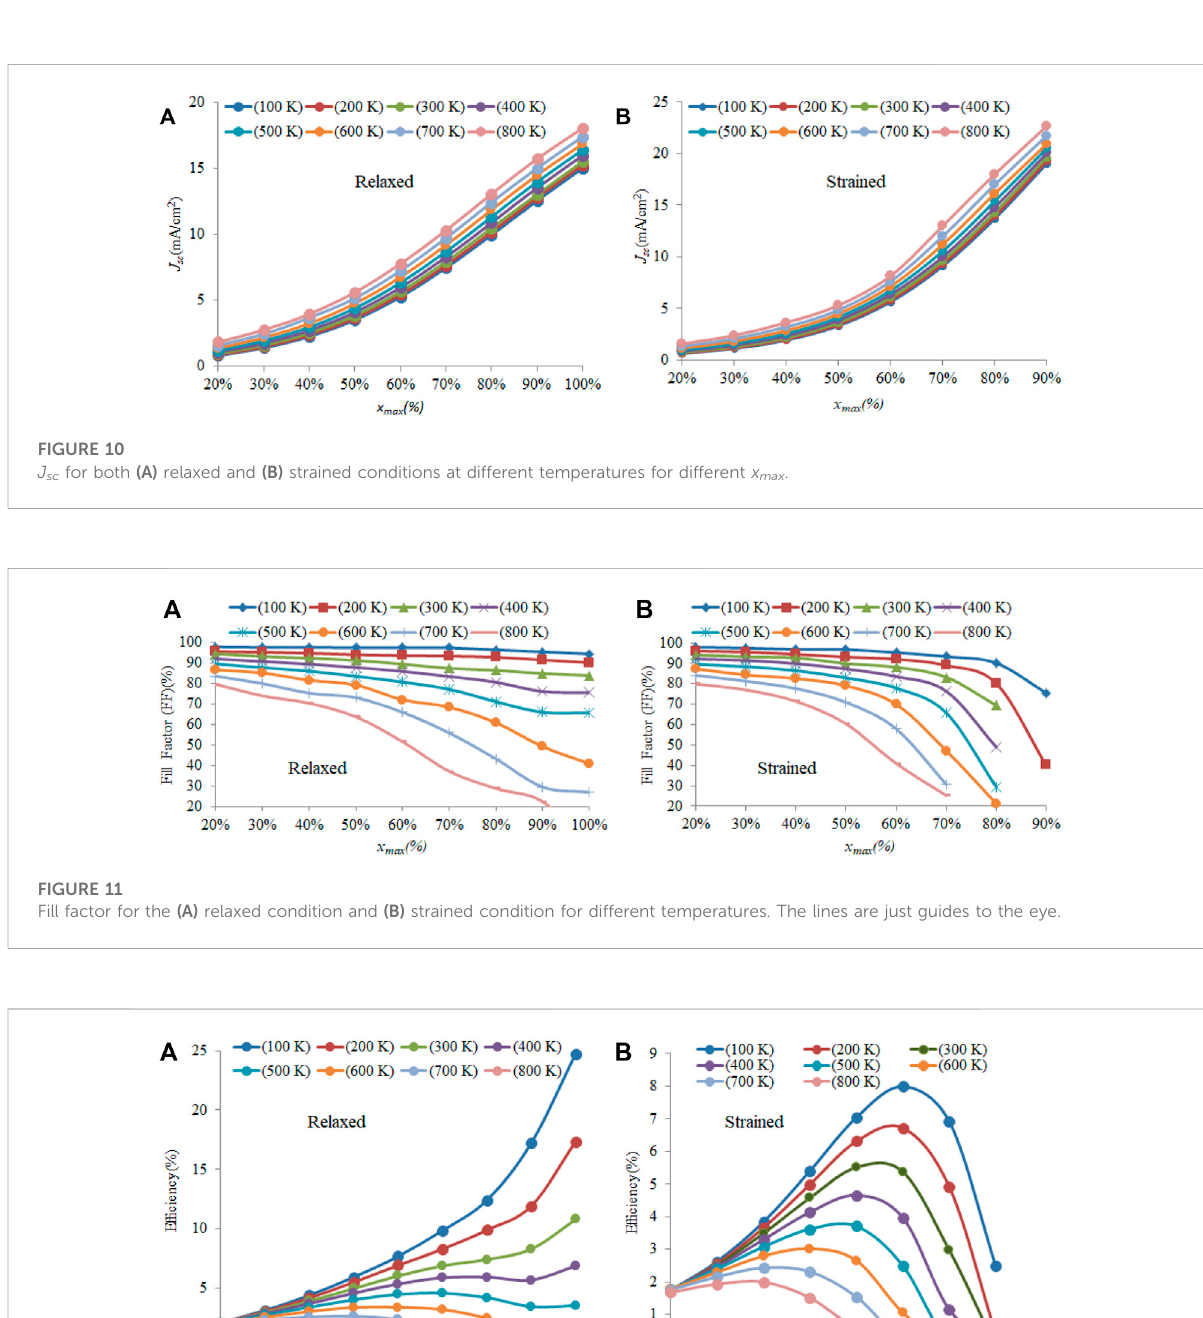
Figure 13 summarizes x max found to maximize the ef fi ciency for each temperature for both the strained and relaxed cases. Here, we see that for the strained structure, the maximum x max decreases monotonically from 71% to